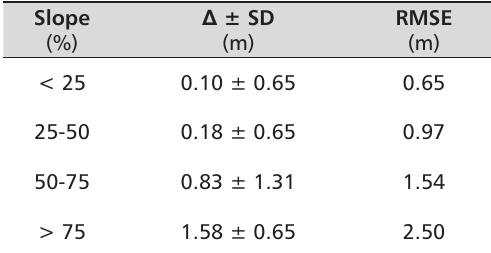
TABLE 4. Differences in tree height obtained with ALS and from terrestrial measurements for forest stands on slopes (according to research of Véga and Durrieu [83]). Note how overestimation of tree height from ALS (positive D ) increases with